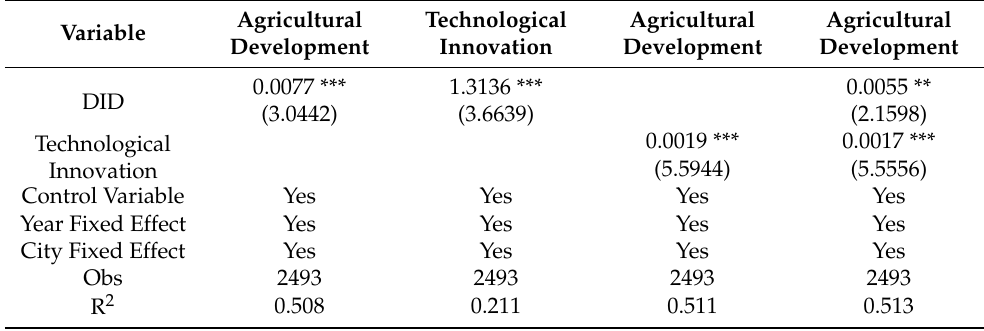
Table 4. Test results of the mediating effect of technological innovation.